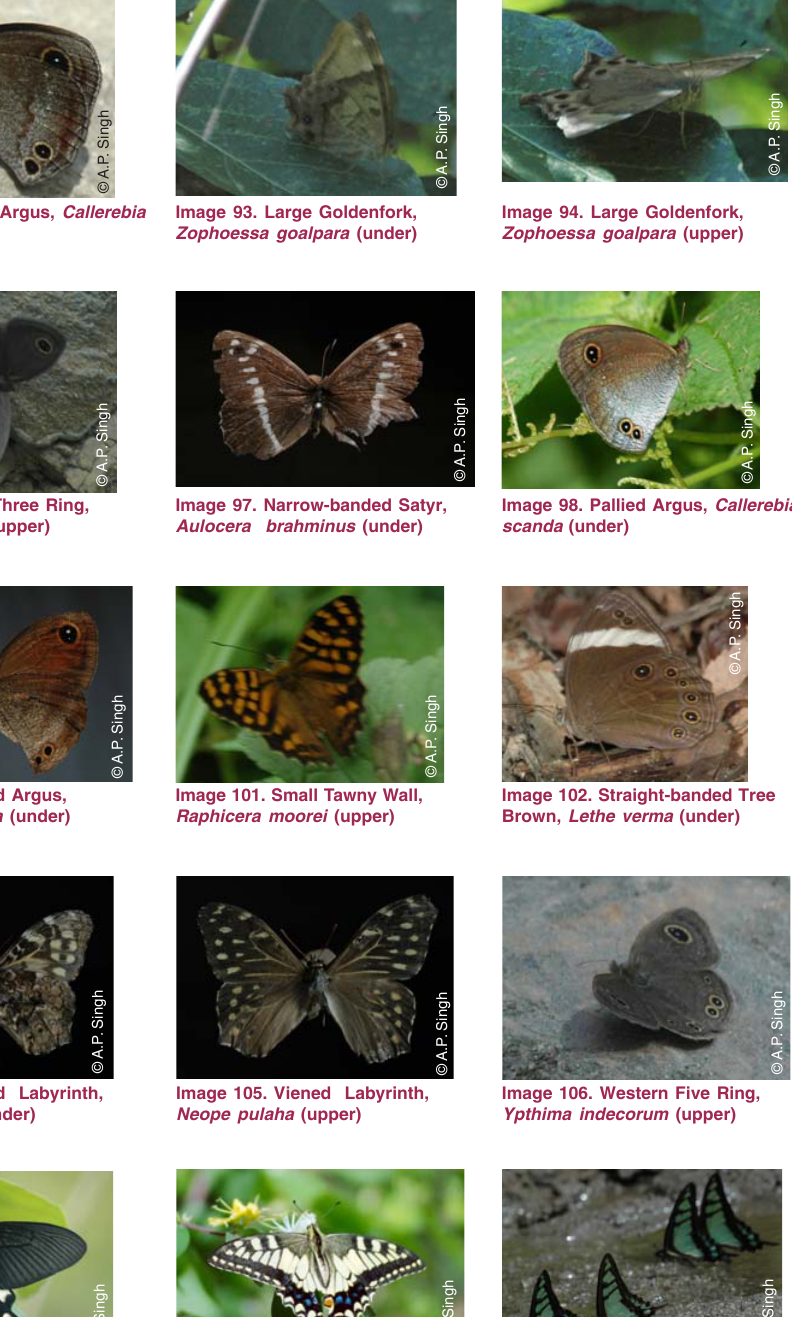
Image 108. Great Windmill, Atrophaneura dasarada